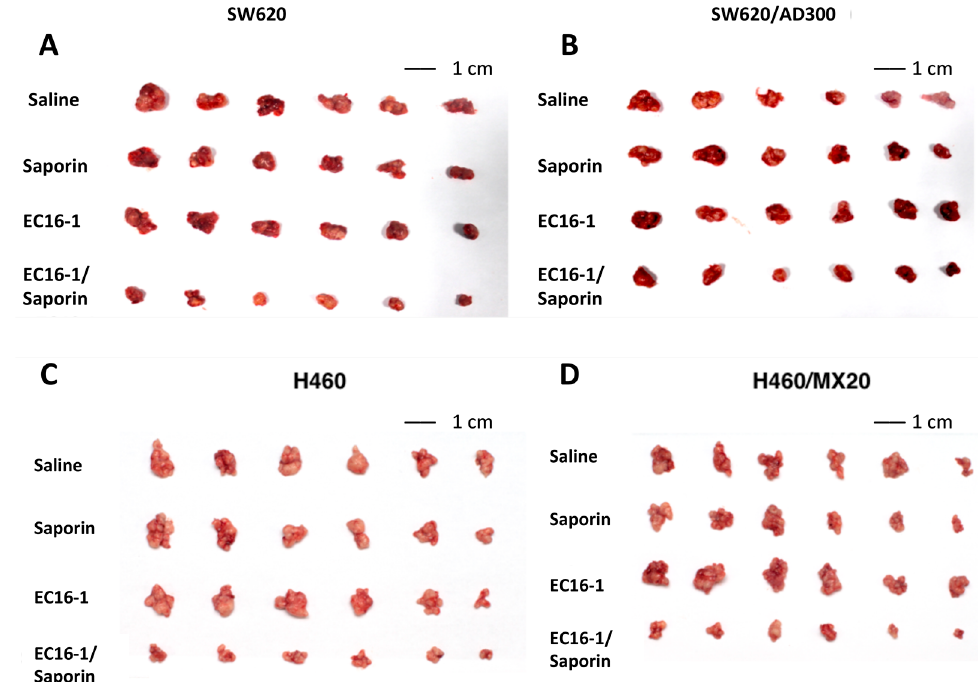
Figure 5. Effect of EC16-1/saporin on the parental and ABCB1 or ABCG2 tumors in nude athymic mice. The images of excised SW620 ( A ) and SW620/AD300 ( B ) tumors implanted subcutaneously in athymic NCR nude mice ( n = 6). Images of the excised NCI-H460 and ( C ) and NCI-H460/MX20 ( D ) tumors implanted subcutaneously in athymic NCR nude mice ( n = 6). The images were taken at the end of the 12-day treatment period.